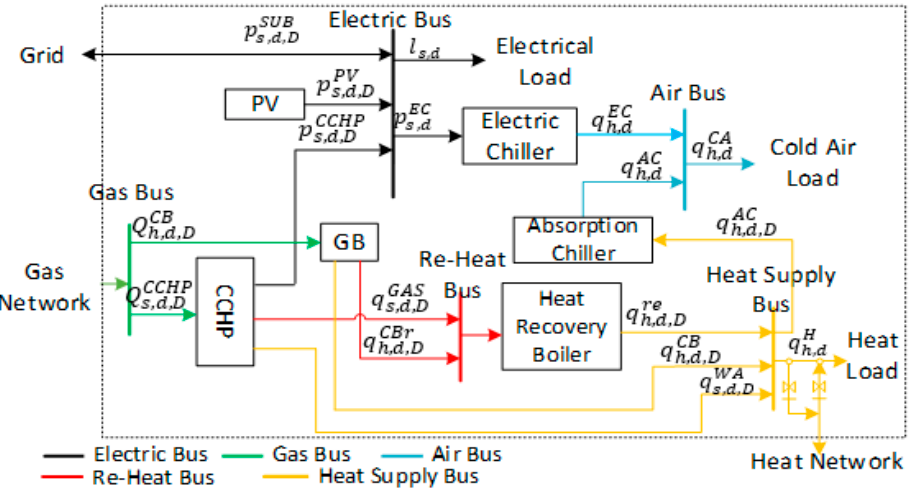
Figure 1. The Busbar structure for the integrated energy systems (IES).